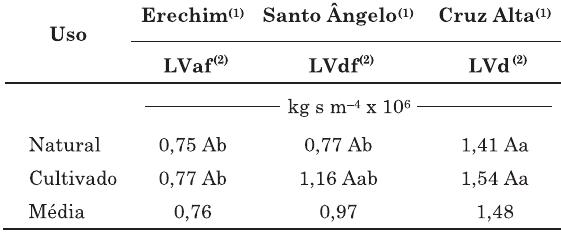
Quadro 4. Fator de erodibilidade do solo em entressulcos (K i